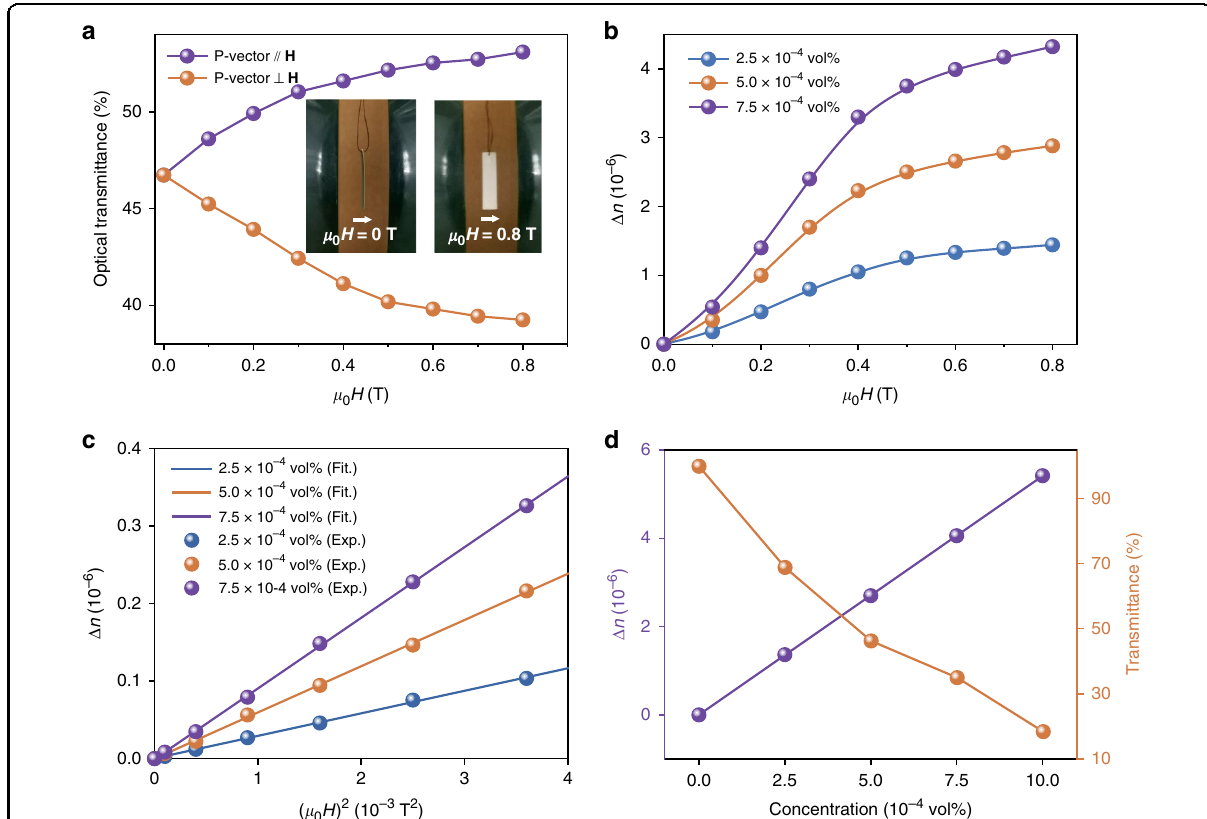
Fig. 4 Magneto-birefringence effect of 2D CTO in the DUV region. a Optical transmittance of 2D CTO LC (5 × 10 – 4 vol%) in parallel and orthogonal directions of magnetic fi eld to Poynting vector (P-vector). Insets: optical images of a layered and oriented CTO fi lm sample rotated from the initial state (without magnetic fi eld, left) to the direction parallel to the fi eld (0.8 T, right). b Magneto-birefringence at different concentrations of CTO. c Birefringence as a function of square of magnetic fi eld in the low fi eld range from 0 T to 0.2 T. d Concentration dependent birefringence and transmittance of CTO at 0.8